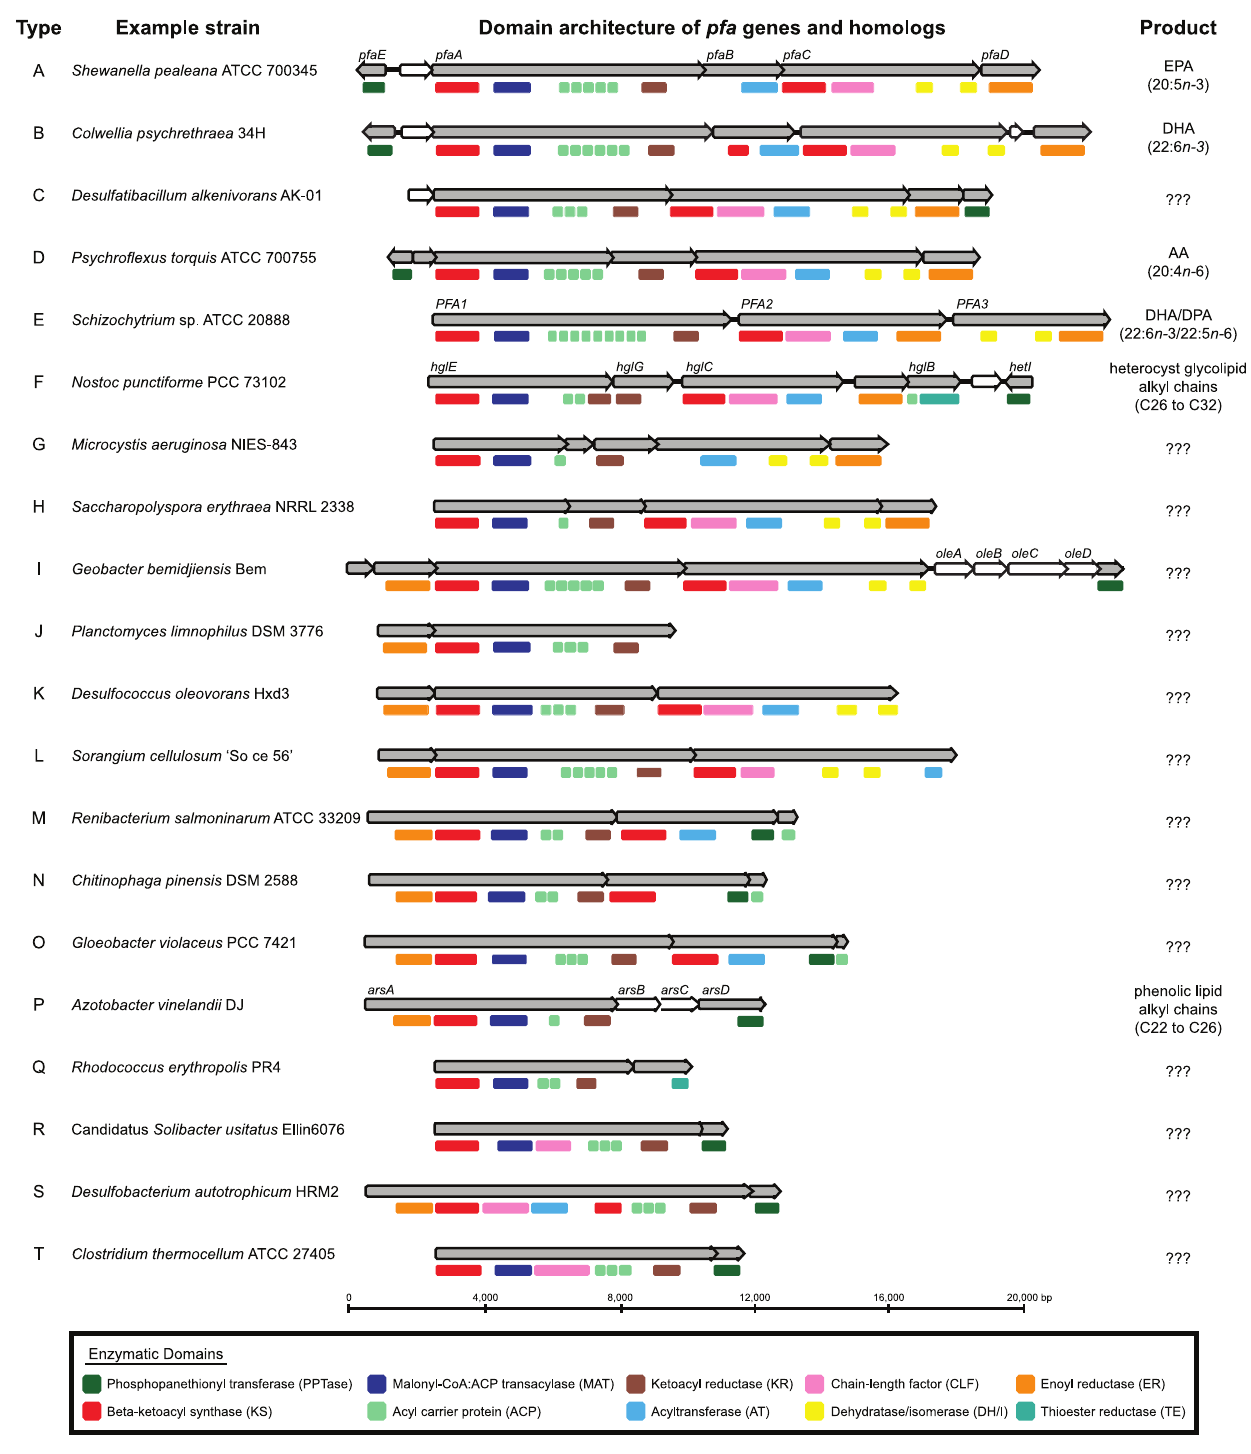
Figure 1. Diversity of pfa -like gene clusters. Eighty-six microbial genomes with either the pfa gene cluster or a homolog were identified. Type designations are based on KS phylogeny, conserved domain structure and product information, if available.